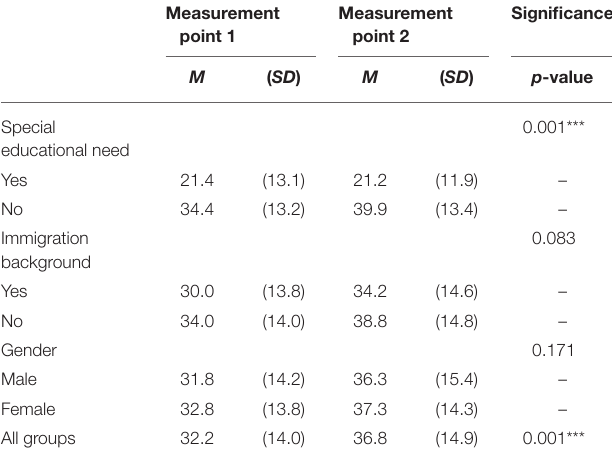
TABLE 4 | Comparison of sum